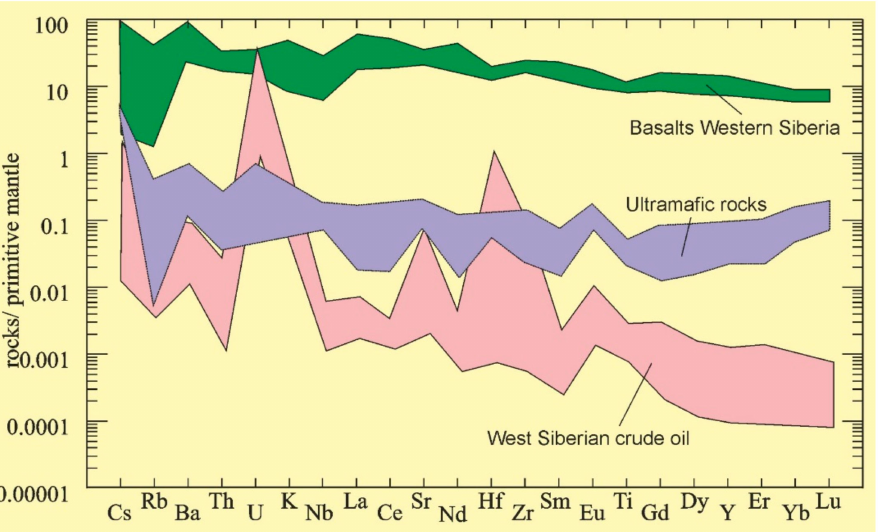
Figure 1. Spider diagram normalized by the composition of the primitive mantle [18] for Priuralskaya crude oil (West